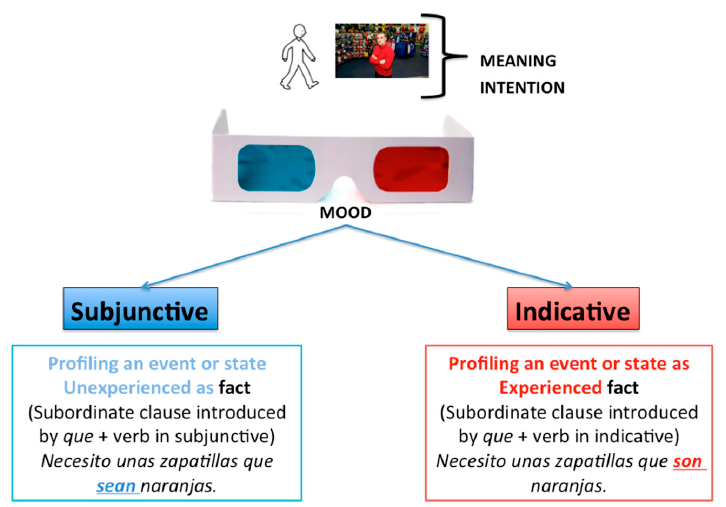
Figure 3. Slide containing the model that was presented to students and that they had to use as a reference to create their own one.